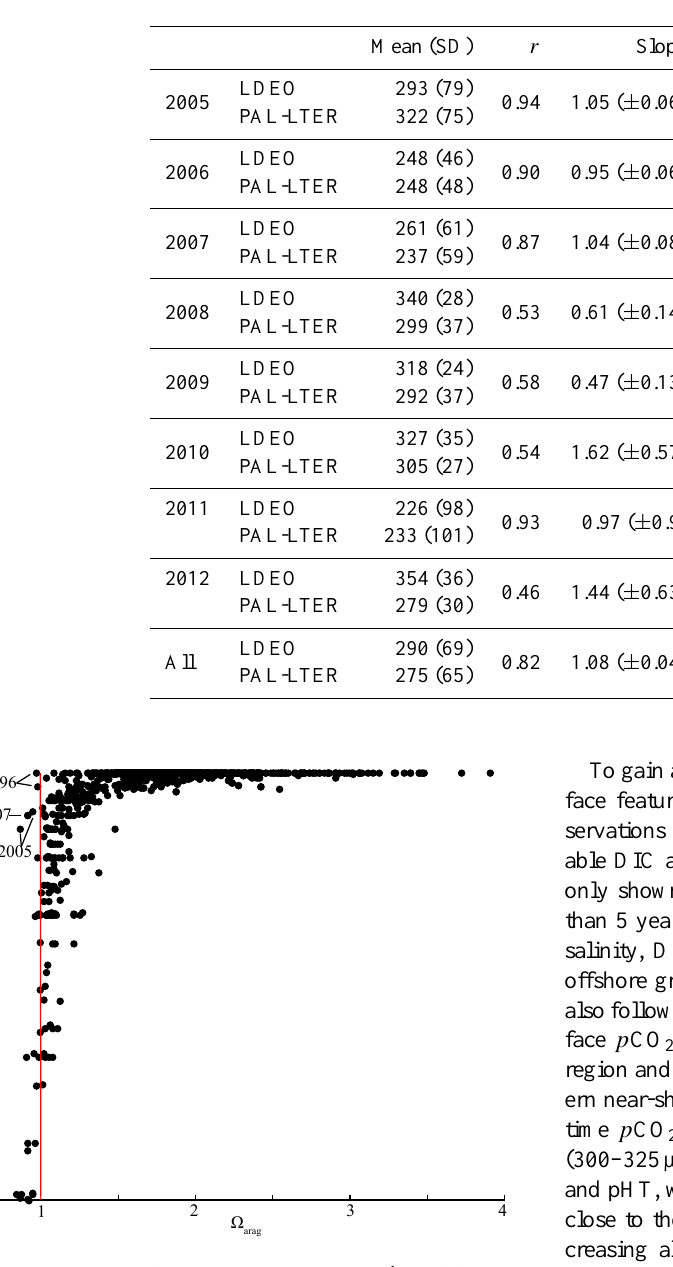
Figure 3. Depth profiles of aragonite saturation state ( (cid:127) arag ) for the years 1993 through 2012. The aragonite saturation horizon for each year is located where the profile crosses the red line ( (cid:127) arag = 1.0).